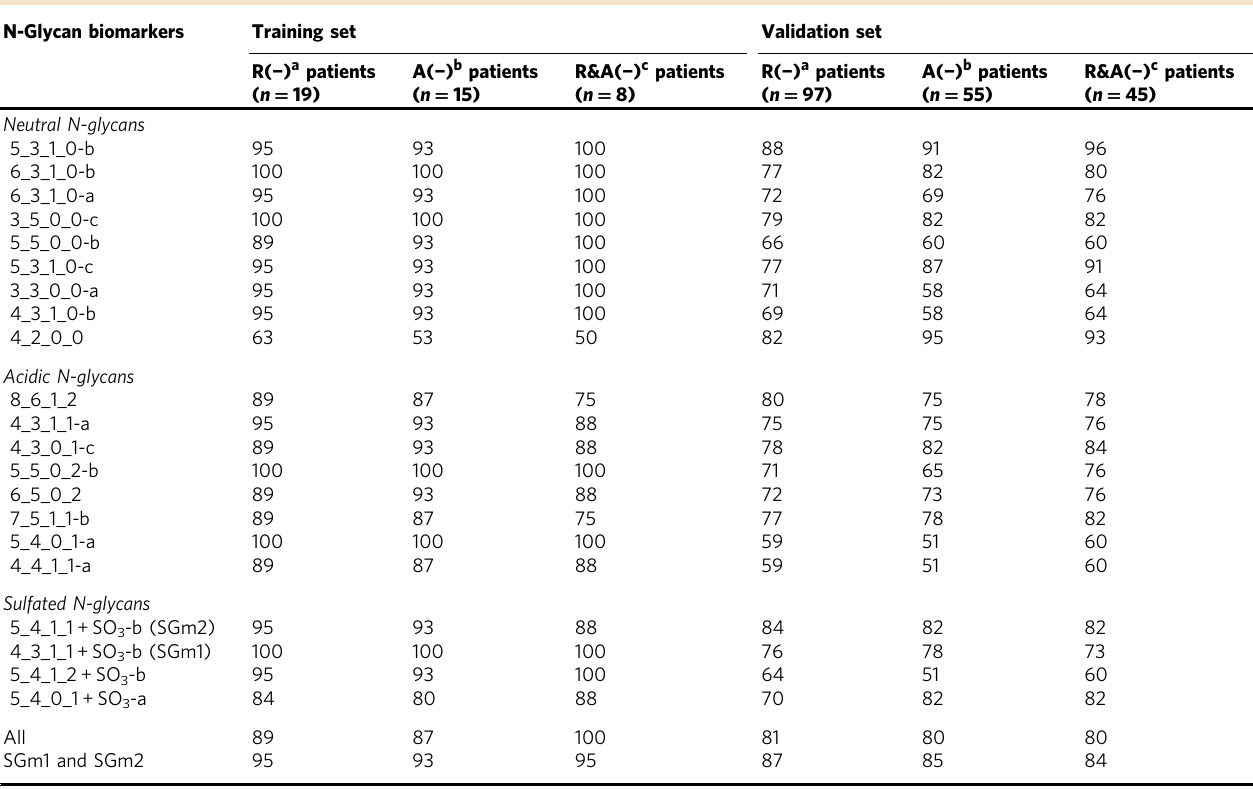
Table 2 Prediction accuracy (%) d of 21 N-glycan biomarkers for RF-negative and/or ACPA-negative patients N-Glycan biomarkers Training